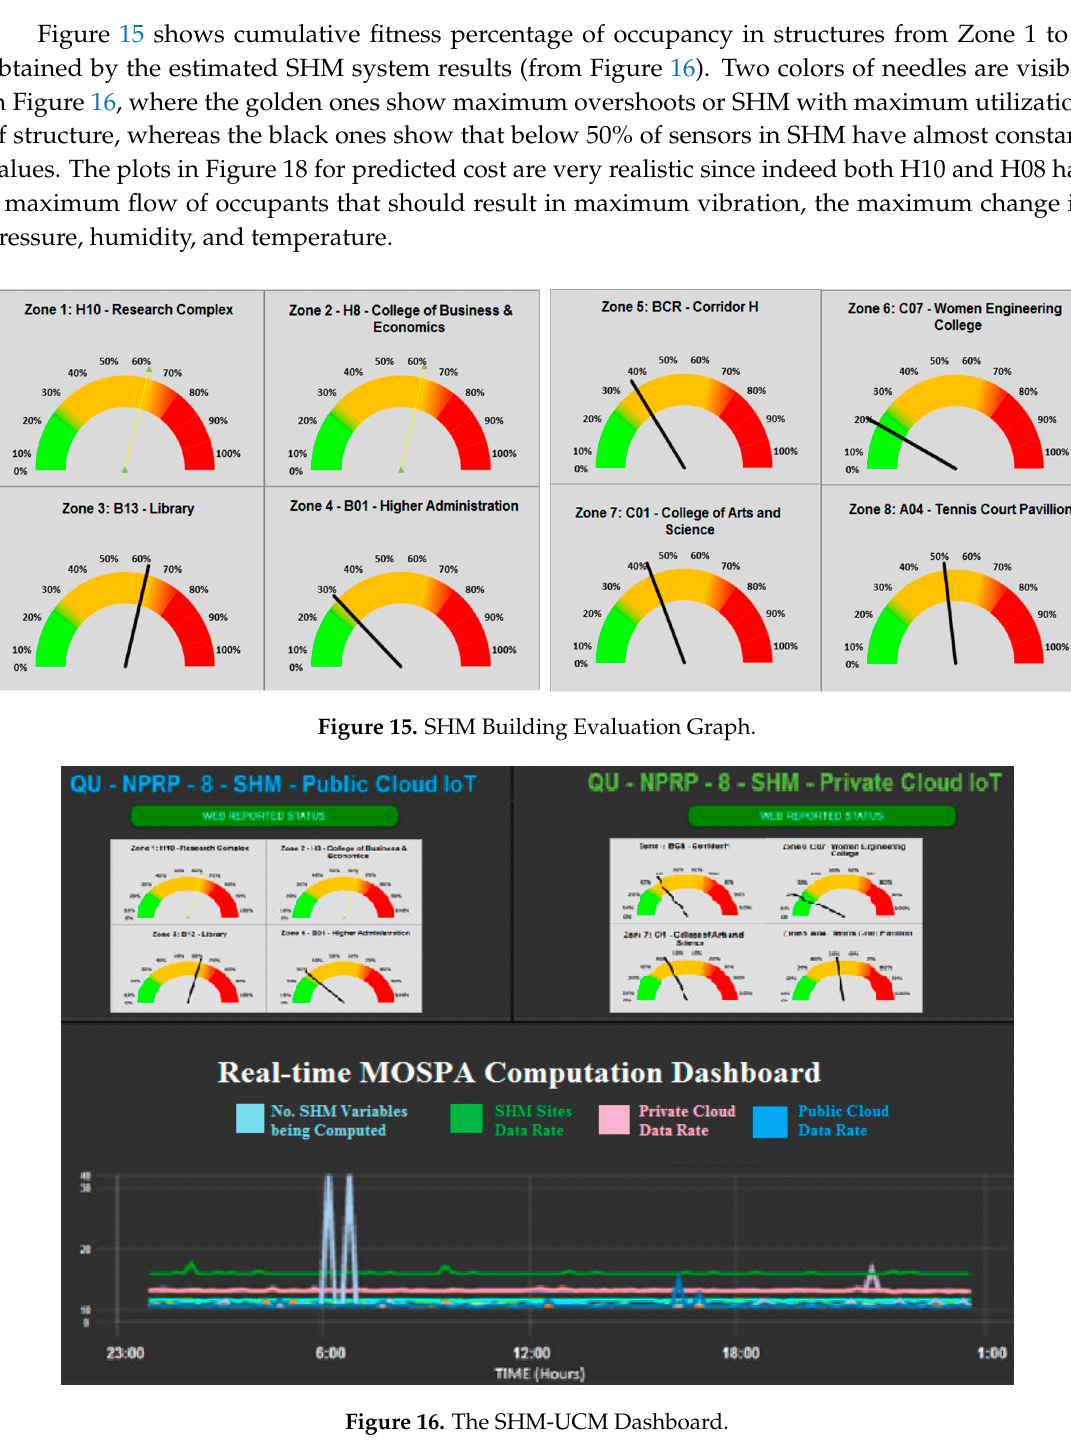
Figure 16. The SHM ‐ UCM Dashboard. Figure 16. The SHM-UCM